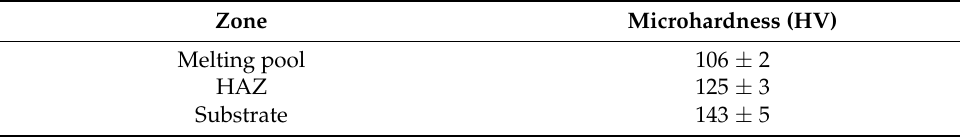
Table 12. Microhardness values of the deposited single tracks.